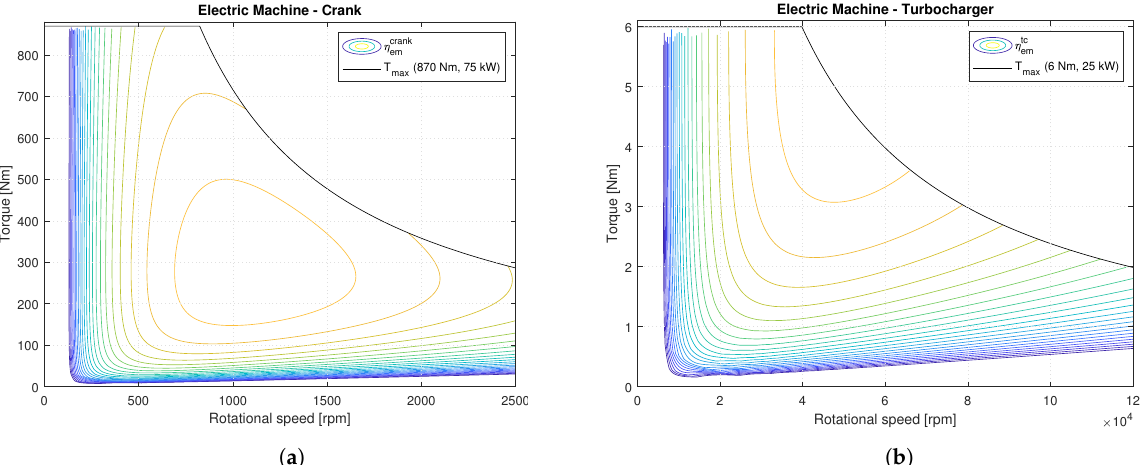
Figure 5. Electric motor characteristics for ( a ) crank shaft motor efficiency lines and the maximum torque restriction, and ( b ) turbocharger efficiency lines and the maximum torque restriction. The maximum efficiency reached by the combined electric motor and inverter for the two models was